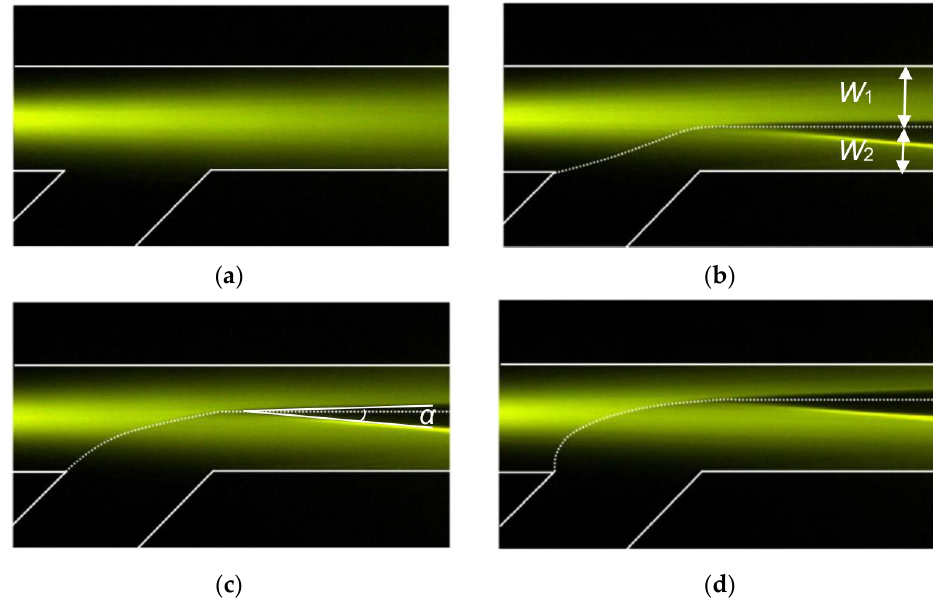
Figure 2. Beam splitter with different flow rate ratios: ( a ) 0, ( b ) 0.43, ( c ) 0.87 and ( d ) 1.5.